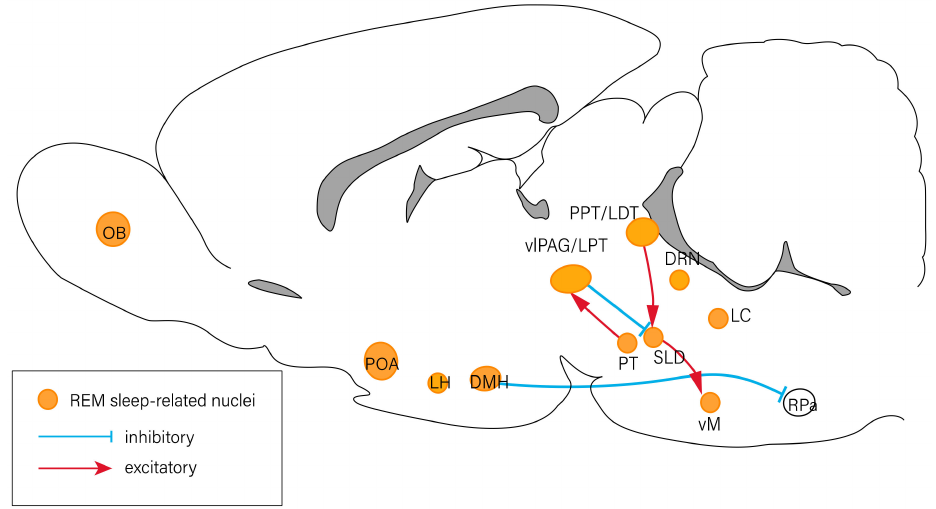
Figure 3. Neural circuits of REM sleep regulation. The OB, POA, LH, DMH, PT, vlPAG/LPT, PPT/LDT, DRN, LC, and vM are associated with the modulation of REM sleep. There exist inhibitory projections (blue lines) and excitatory projections (red lines) between nuclei. DMH: dorsomedial hypothalamus; DRN: dorsal raphe nucleus; LC: locus coeruleus; LDT: laterodorsal tegmental nucleus; LH: lateral hypothalamus; LPT: lateral pontine tegmentum; OB: olfactory bulb; POA: preoptic area; PPT: pedunculopontine tegmental nucleus; PT: pontine tegmentum; RPa: raphe pallidus area; vlPAG: ventrolateral periaqueductal gray; vM: ventral